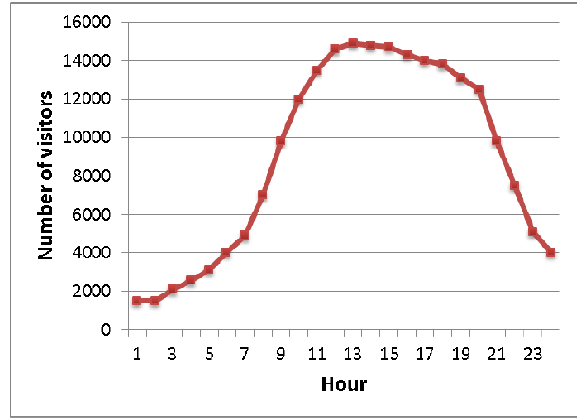
Figure 2: City of Split: average number of visitors per day, segmentation by age (time interval: 1st June – 31th August)